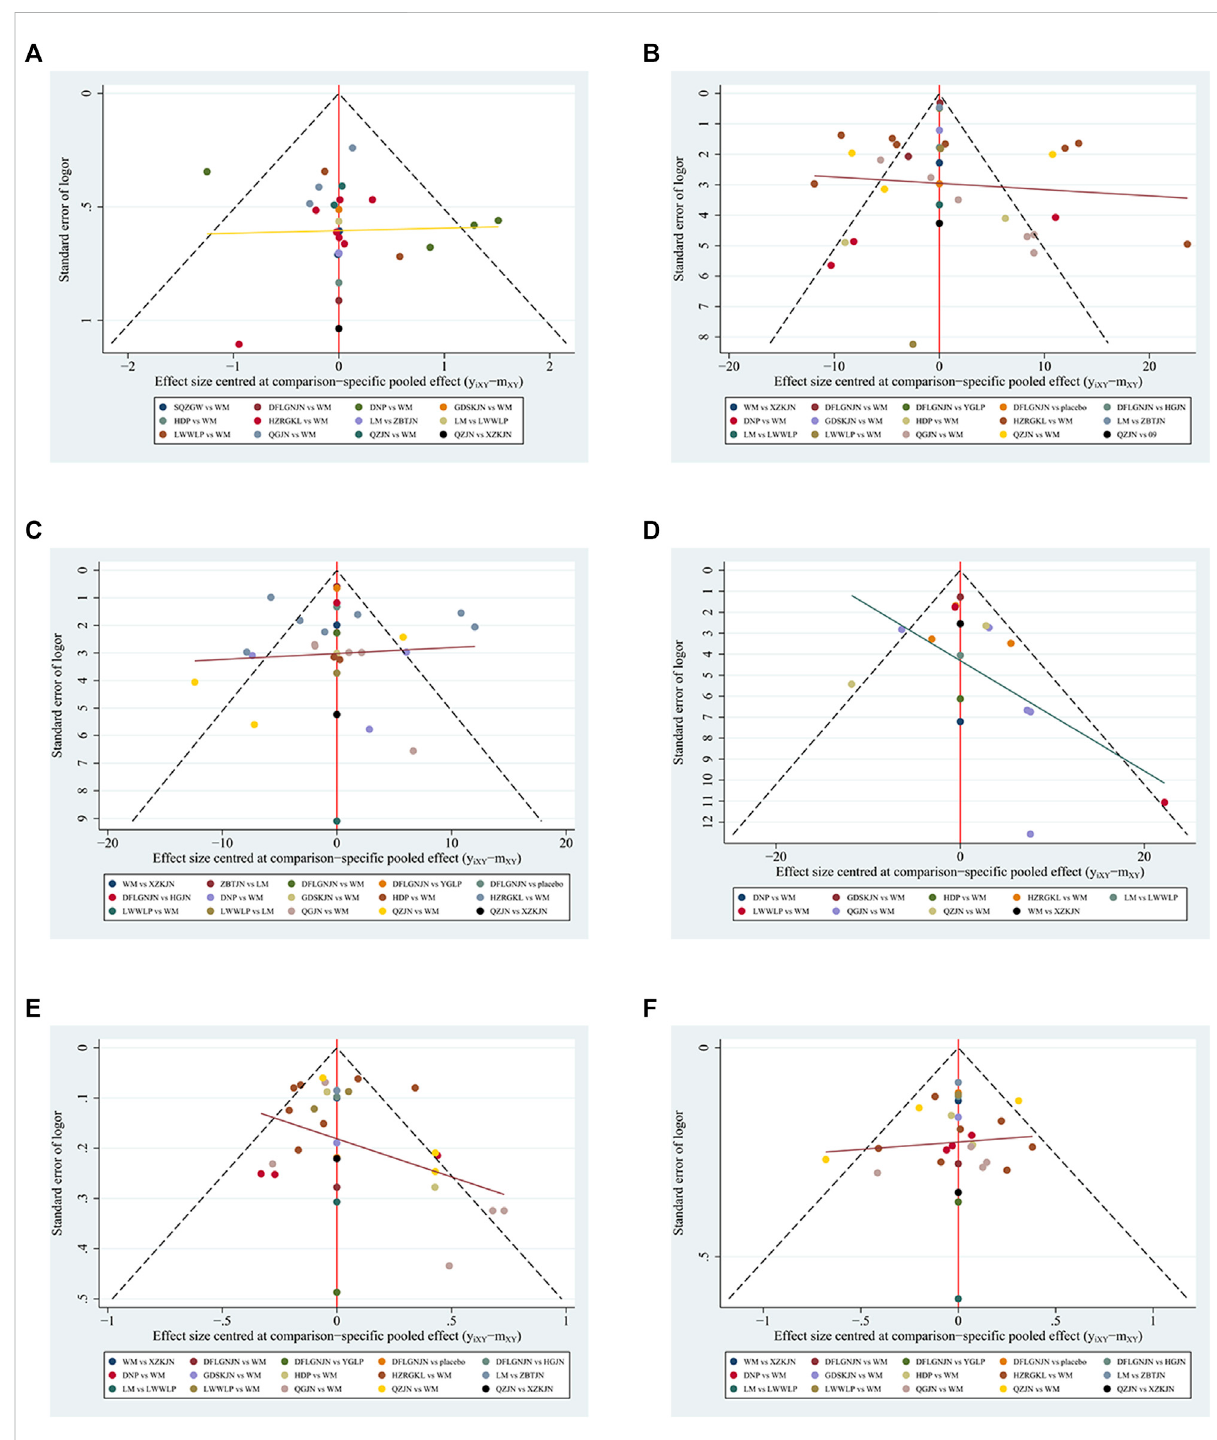
FIGURE 5 Funnel plots (A) Clinical ef fi ciency rate (B) ALT (C) AST (D) GGT (E) TG (F) TC; WM, Western medicine; QGJN, Qianggan capsule; DFLGNJN, Dangfei Liganning capsule; DNP, Danning tablets; HZRGKL, Huazhi Rougan granule; QZJN, Qiaozhi capsule; SQZGW, Sanqi Zhigan pill;